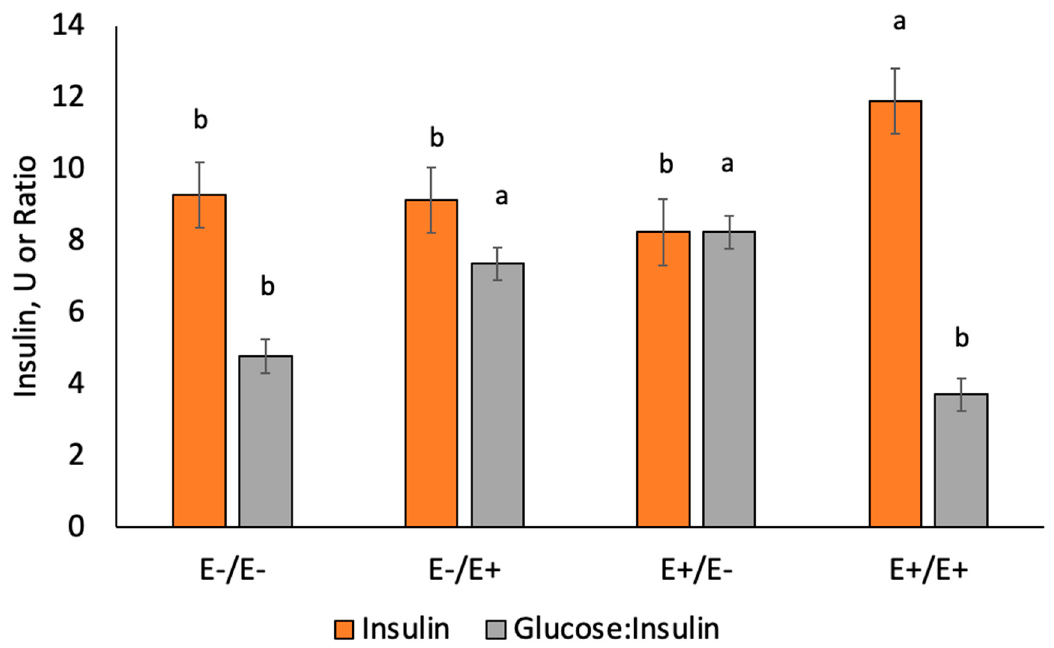
Figure 4. Average plasma insulin (U) concentrations and glucose to insulin ratio during gestation for ewes fed E − or E + seed. Superscripts denote significance ( a,b p < 0.05) by variable. Serum NEFA values were decreased ( p = 0.038) for E+/E+ compared to E+/ E− and E− / E− (d 85 to 133; Figure 5). Serum NEFA was highest ( p < 0.001) on d 133 versus d 85 and 105 (data not shown). The RQUICKI values were highest ( p = 0.0008) for E+/E+ and lowest for E+/ E− across gestation. The RQUICKI values decreased ( p < 0.0001) during LATE gestation (data not shown) but all interactions with day were non-significant.